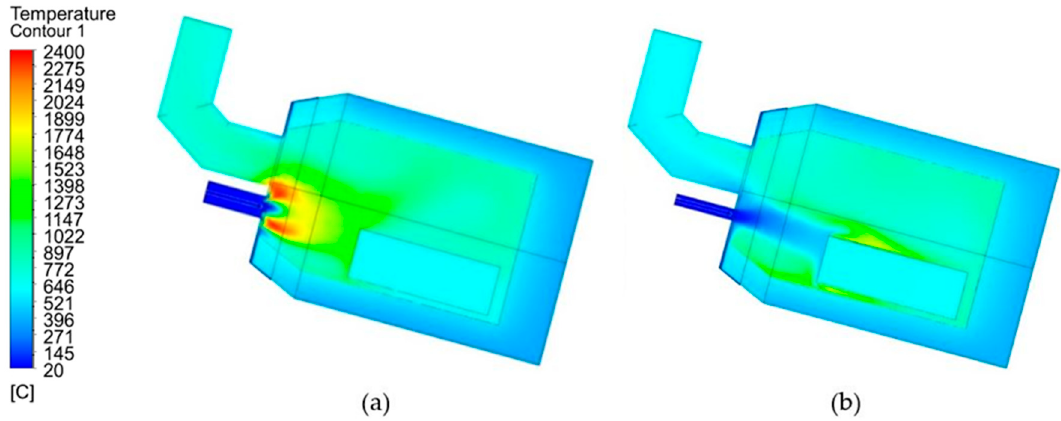
Figure 12. Model results: distribution of temperature contours ( a ) OEC technology, ( b ) OEC technology +modification of burner.